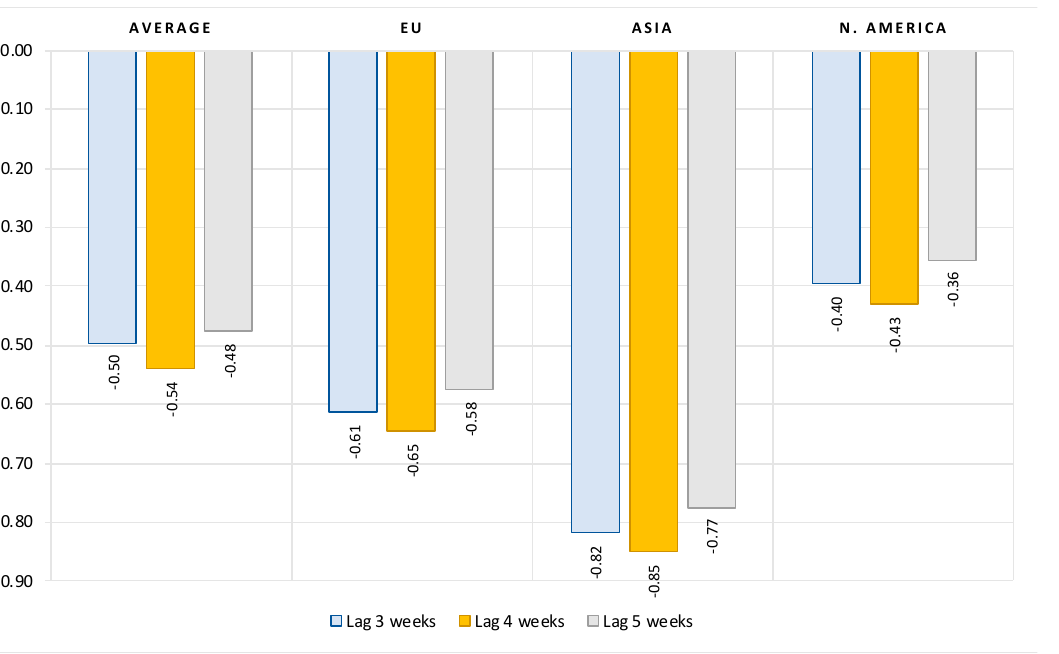
Figure 5. Impact of vaccination rate on number of new ICU patients, limited data sample *. Notes: Figure contains the estimated elasticities of the per-million number of new ICU patients to